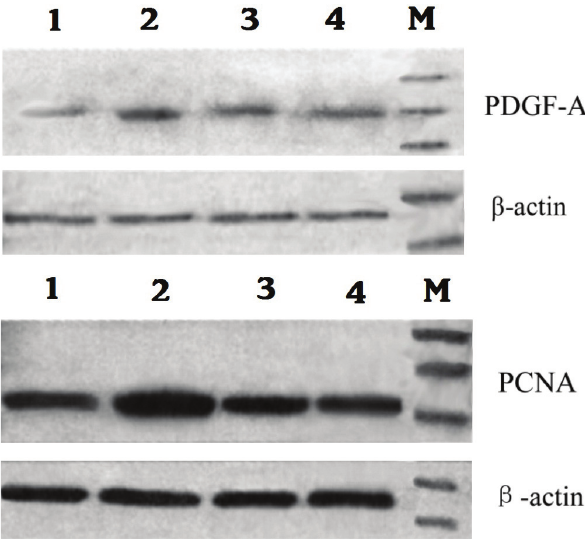
Fig. 2. Western blot results of PCNA and PDGF-A. M: marker; 1: normal group; 2: model group; 3: simvastatin group; 4: high- dose puerarin